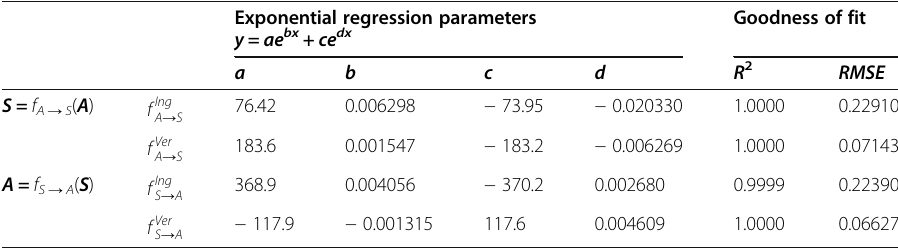
Table 1 Parameters of the double-exponential function used to model the relationship between single-count rates S and activity concentration A = f S → A ( S ), and the inverse relationship between activity concentration A and single-count rates S = f A → S ( A ), both for the ingenuity ( f Ing ) and Vereos ( f Ver ) cameras. Two goodness-of-fit criteria are additionally provided for each regression: the coefficients of determination ( R 2 ) and the root mean square error